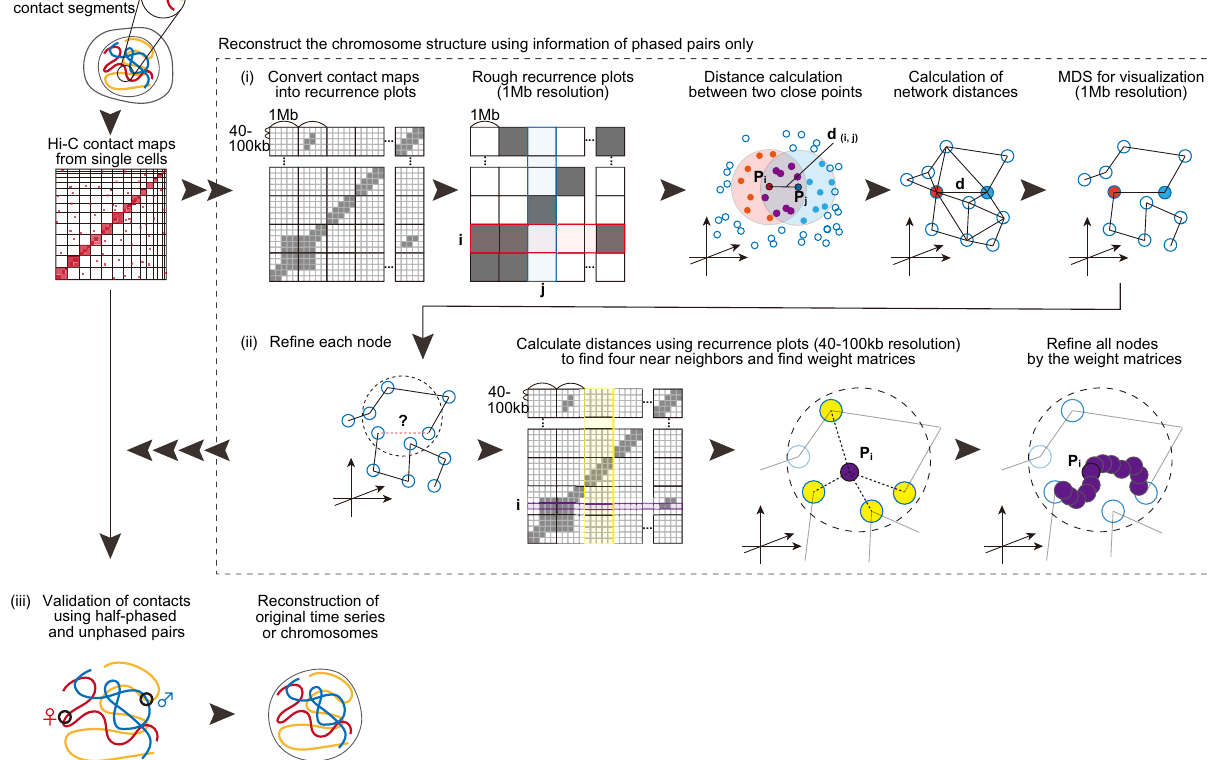
Figure 1. Graphic summary of the reconstruction of the 3D structure for chromosomes given single-cell Hi-C data using the recurrence plot-based